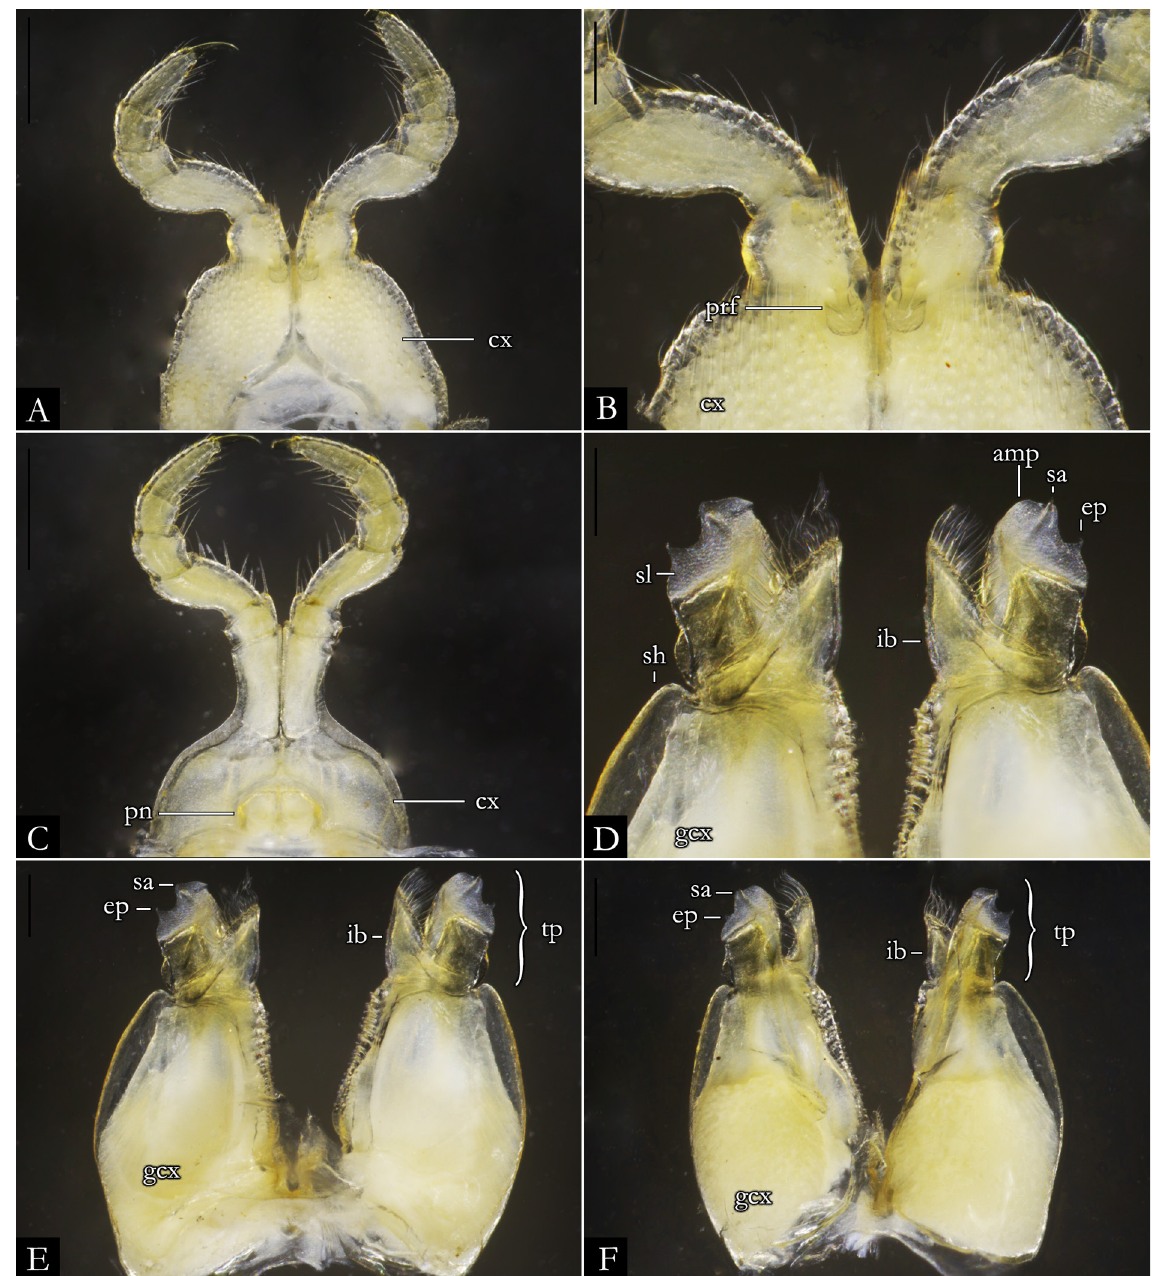
Fig. 73. Pseudonannolene imbirensis Fontanetti, 1996, holotype, ♂ (MZSP 1035). A . First leg-pair. B . Detail of prefemur. C . Second leg-pair. D . Detail of telopodites, in anal view. E . Gonopods, in anal view. F . Gonopods, in oral view. Abbreviations: see Material and methods. Scale bars: A, E–F = 0.5 mm; B–D = 0.2